Question: Write a single sentence explaining what this figure depicts.
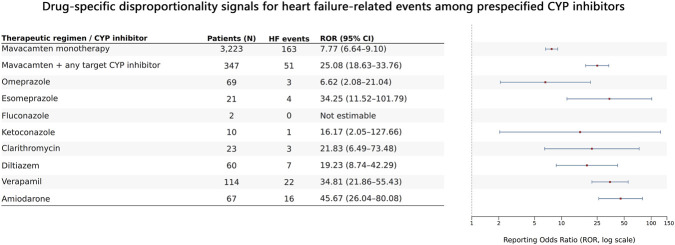
Answer: Drug-specific disproportionality signals for heart failure-related reports among prespecified CYP inhibitors. Forest plot showing reporting odds ratios (RORs) and 95% confidence intervals (CIs). Drug-specific counts correspond to Supplementary Table S2 . Rows are not mutually exclusive because individual reports may contain more than one CYP inhibitor. Abbreviations: CYP, cytochrome P450; ROR, reporting odds ratio; CI, confidence interval.